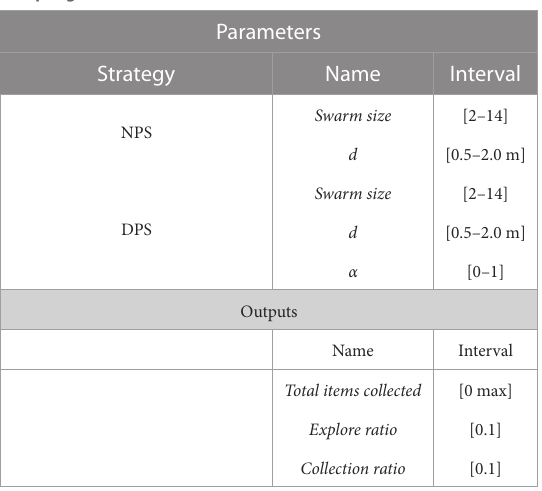
TABLE1 ParametersandoutputsusedfortheLatinhypercube sampling.